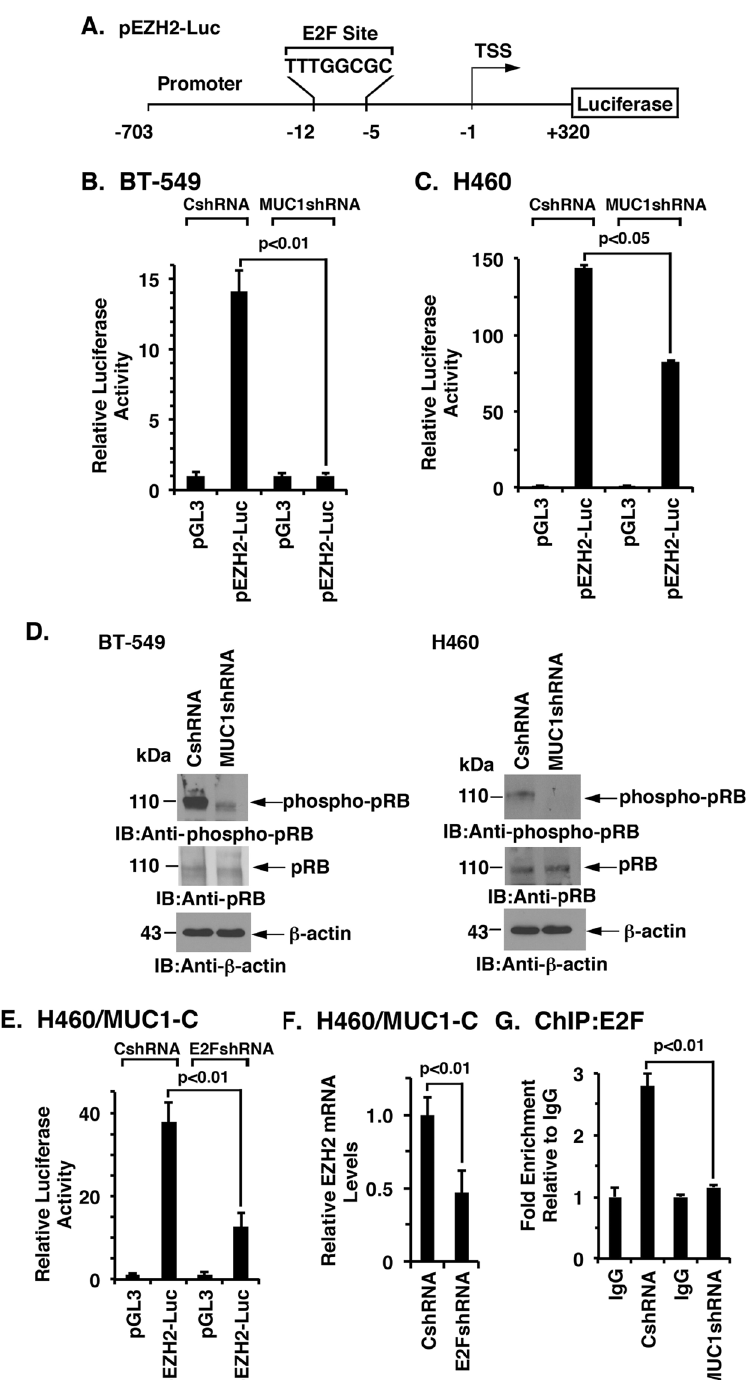
Figure 3. Targeting MUC1-C suppresses the EZH2 promoter. ( A ) Schema of the pEZH2-Luc vector with positioning of the E2F binding site at − 12 to − 5 bp upstream of the transcription start site. ( B and C ) The respective BT-549 ( B ) and H460 ( C ) cells expressing a CshRNA or MUC1shRNA were transfected with the pGL3-Basic Luc or pEZH2-Luc reporter for 48 h and then analyzed for luciferase activity. The results (mean ± SD of 3 determinations) are expressed as the relative luciferase activity compared to that obtained with pGL3-Basic Luc (assigned a value of 1). ( D ) Lysates from the respective BT-549 (left) and H460 (right) cells expressing a CshRNA or MUC1shRNA were immunoblotted with the indicated antibodies. ( E ) H460/MUC1-C cells were transduced with lentiviral vectors to express a control shRNA (CshRNA) or a E2F shRNA. The cells were transfected with the pGL3-Basic Luc or pEZH2-Luc reporter for 48 h and then analyzed for luciferase activity. The results (mean ± SD of 3 determinations) are expressed as the relative luciferase activity compared to that obtained with pGL3-Basic Luc (assigned a value of 1). ( F ) The respective H460/MUC1-C cells were analyzed for EZH2 mRNA levels by qRT-PCR. The results (mean ± SD) are expressed as relative mRNA